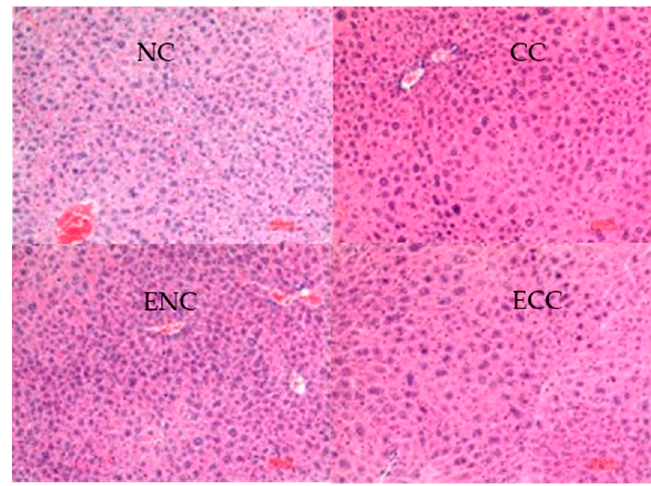
Figure 2. Liver histopathological tissue sections of Institute of Cancer Research (ICR) mice.